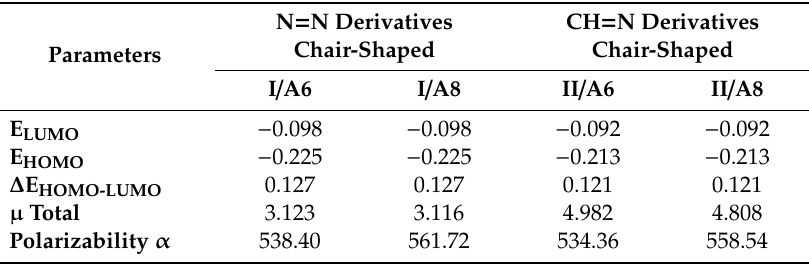
Table 4. FMO energies a.u., polarizability, α , and dipole moment µ (Debye) of geometrical conformers of HBSMCs, ( I,II) / A(6,8) .